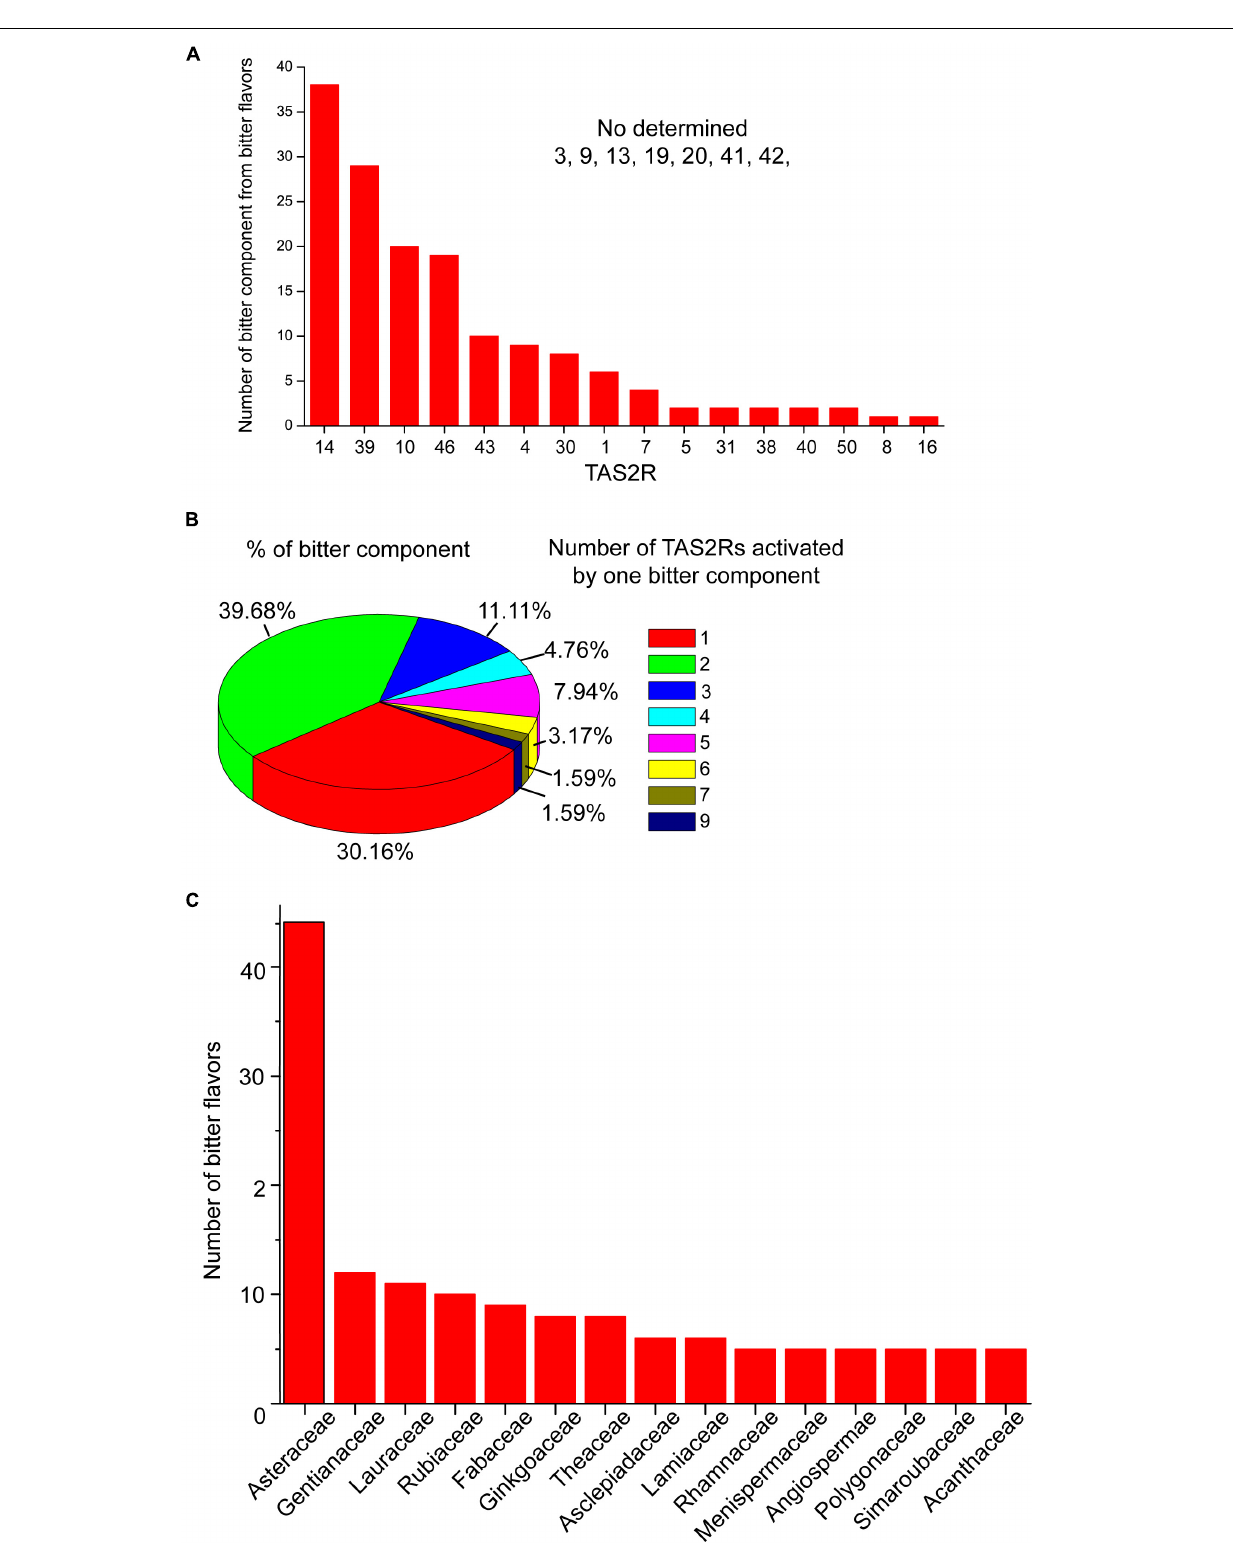
FIGURE 1 | The activation profile of TAS2Rs by bitter components from bitter flavored TCM. (A) Bar graph shows the TAS2Rs that can be activated by different bitter components. (B) The profile of bitter components which can activate different number of TAS2Rs. (C) The family in which bitter components with specific TAS2R have been found. The primary data are shown in Supplementary Table S1